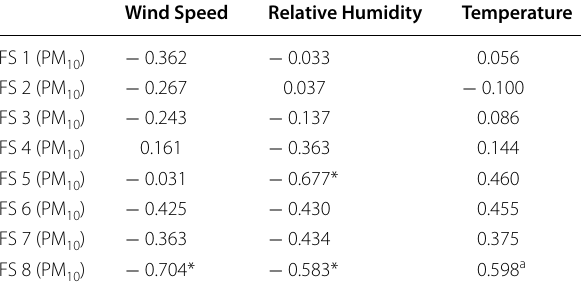
a Means significant at p < 0.05 Table 3 Influence of meteorological parameters on the concentration of PM 10